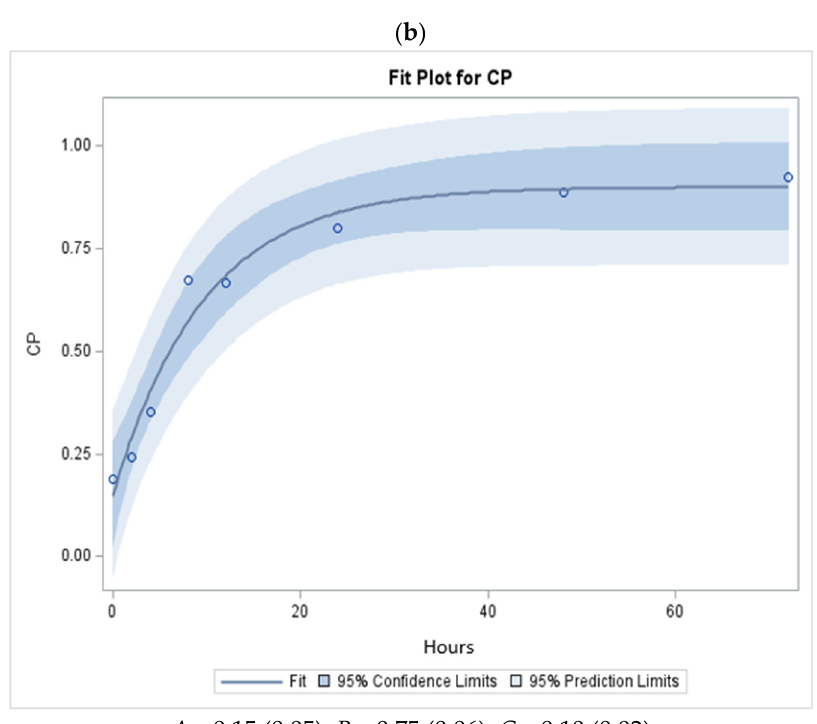
Figure 1. Nonlinear models for the estimation of degradation of ( a ) DM and ( b ) CP. A is the intercept of the curve at 0 h representing the highly soluble fraction; B is the asymptote representing the potentially degradable fraction; C is the fractional rate constant for degradation of B; L is the time lag. The parameters (A, B, A + B, C, L) of degradation were estimated from the solution